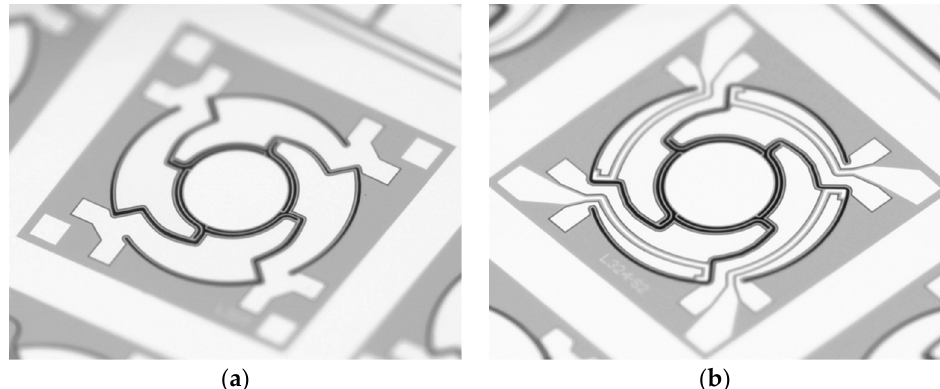
Figure 8. Microscope image of the spring structures of a fabricated micromirror of Design 2. Technological deviations led to smaller resulting spring widths: ( a ) The 10 µm springs have a resulting width of 8.5 µm ( b ) The 7.5 µm springs have a resulting width of 6.0 µm.